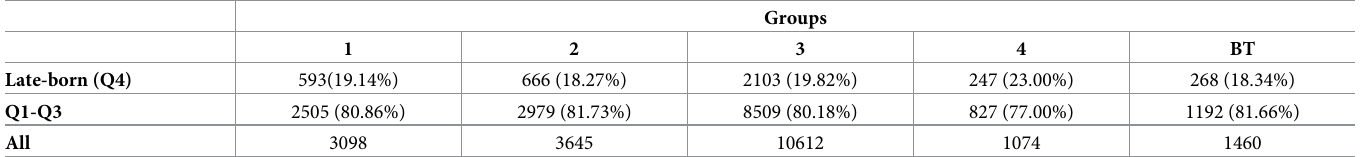
Table 2. Distribution of “late-born” players in various groups.